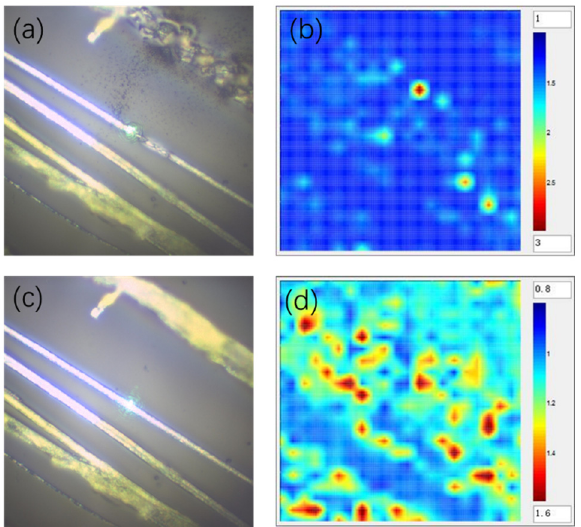
Figure 5. ( a ) The OM images of perovskite MWs; ( b ) the Raman mapping of the crystallization improving factor (I105/I97 ratio) before the laser annealing process; ( c ) the OM images of perovskite MWs; and ( d ) the Raman mapping of the crystallization improving factor (I 105 /I 97 ratio) after the laser annealing process.